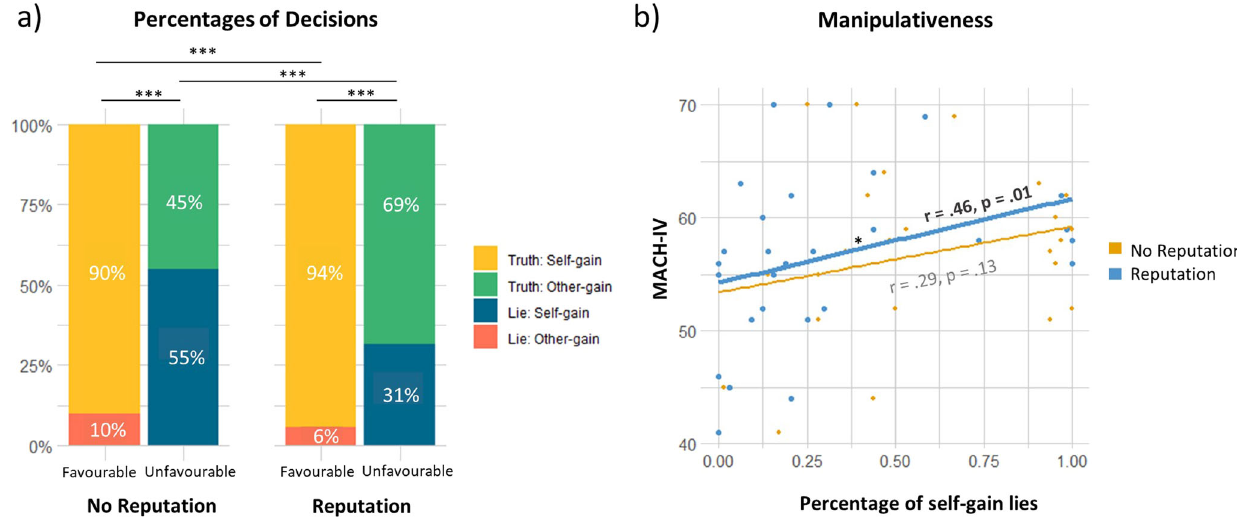
Fig. 1 Decision-making percentages and correlations with levels of manipulative traits. a Percentages of decisions for each reputation condition (No Rep or Rep) and within each outcome (Fav or UnFav) ( N = 28). b Correlation graph of individuals ’ Machiavellian scores with the percentages of self-gain lies during no reputation risk (yellow) and reputation risk (blue) conditions ( N = 28). The line plot in bold depicts signi fi cance. MACH-IV Machiavellian questionnaire